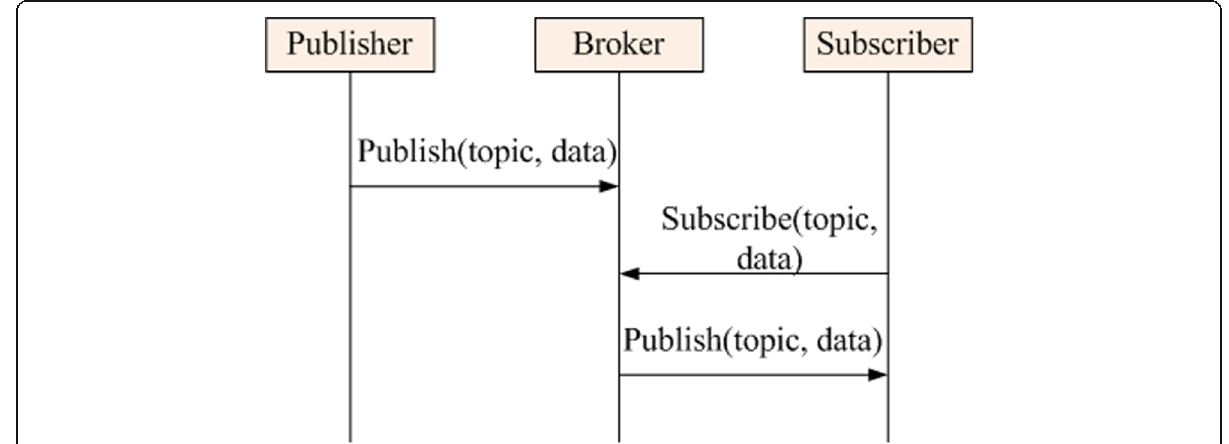
Fig. 1 MQTT Publish/Subscribe topic message model [22]